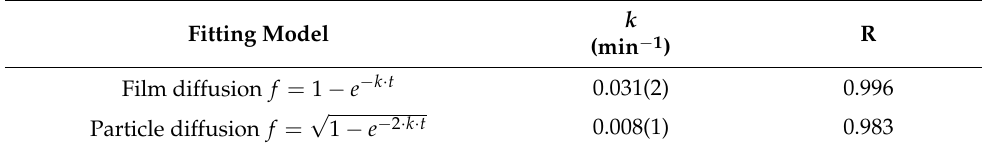
Figure 5. Sorption kinetics of IRB on MIP-polyHIPE (1:15) after template removal. Discontinuous procedure: 15 mg of sorbent contacted with 0.1 M acetate buffer at pH 5 containing IRB 12 µM for varying times. Dotted lines are the fitting by the HPDM model (homogeneous particle diffusion model): blue dotted line represents fitting by film diffusion, pseudo-first order equation; red dotted line represents fitting by particle diffusion, pseudo-second-order equation. Experimental points are reported as average values of five replicates, and the error bars correspond to the standard deviation. Table 2. Sorption kinetics of IRB on MIP-polyHIPE (1:15). Experimental conditions: 15 mg of sorbent contacted with 0.1 M acetate buffer at pH 5 containing IRB 12 µ M for varying times. R = correlation coefficient. Numbers in parentheses are the standard deviation on the last digits. T = 25 ◦